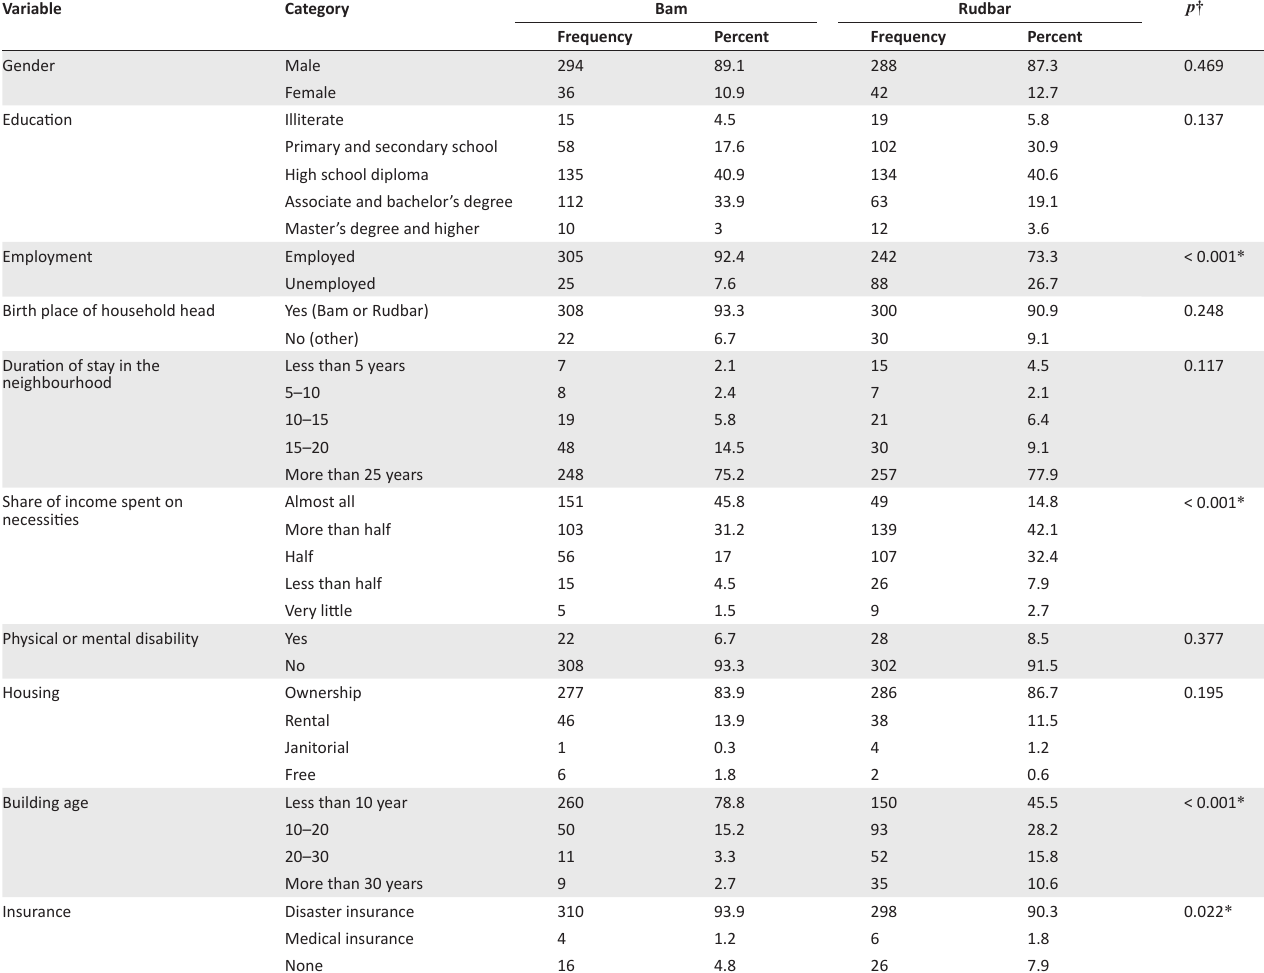
TABLE 4: Comparison of demographic, social and economic characteristics between Bam and Rudbar cities (categorical